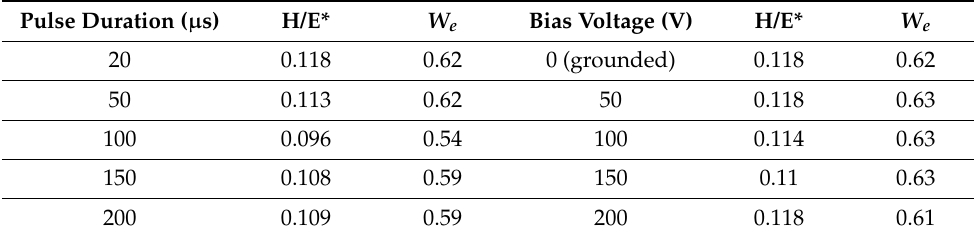
Table 4. H/E* and W e of deposited coatings.